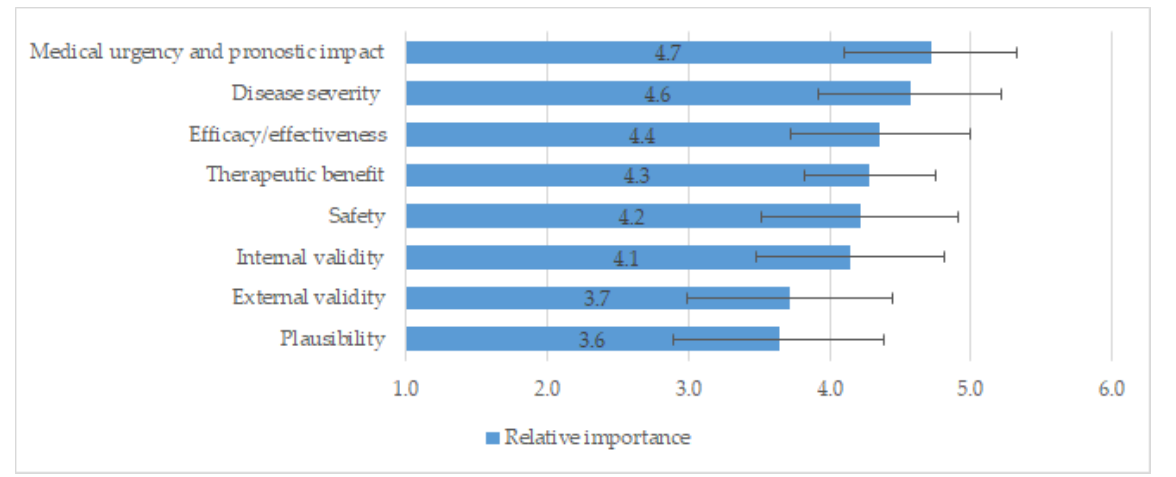
Figure 1. Mean (SD) of relative importance rated by participants to final early access framework.